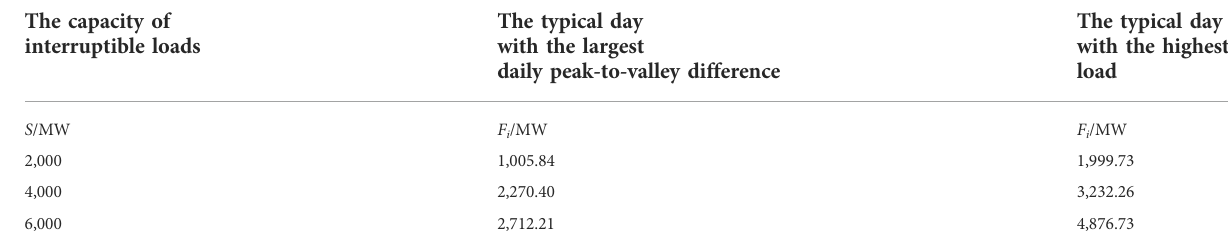
TABLE 2 Results of the capacity value of interruptible